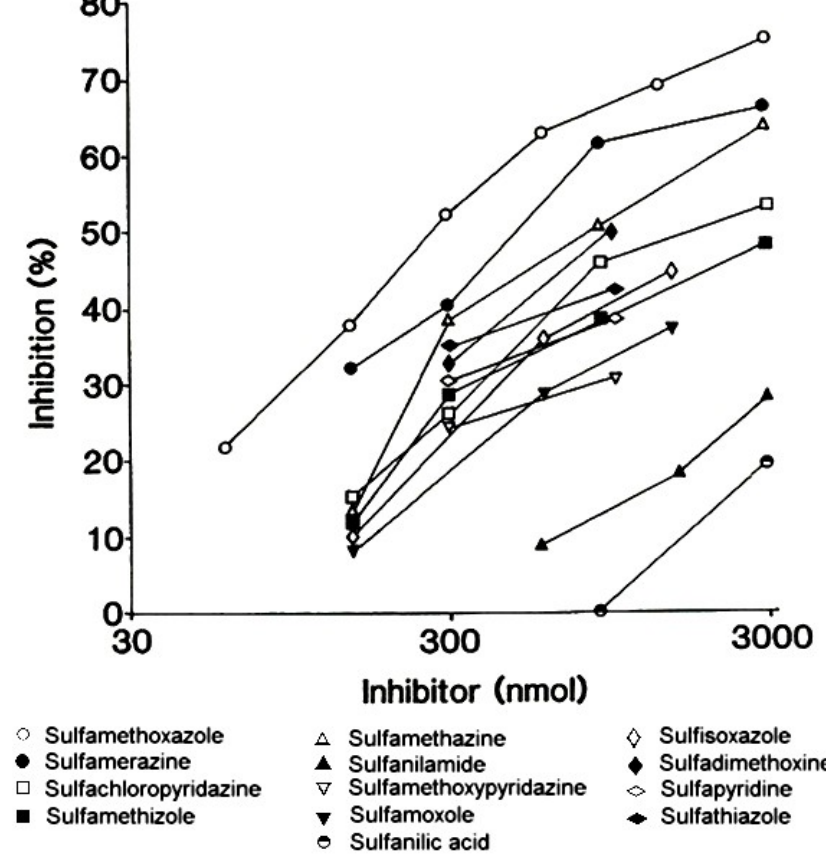
Figure 9. Quantitative structure-activity comparisons of sulfonamide inhibitors of the binding of IgE antibodies to a sulfamethoxazole solid phase. The most potent inhibitors, that is the structures providing the ‘best fit’ to the antibody combining sites were, in order, sulfamethoxazole, sulfamerazine and sulfamethazine. From Harle DG et al. [24]. Reprinted with permission from Elsevier